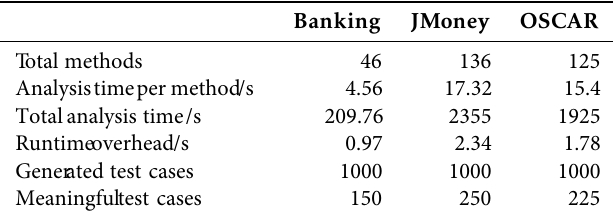
Table 4. ExperimentalData UsingESC/Java2.